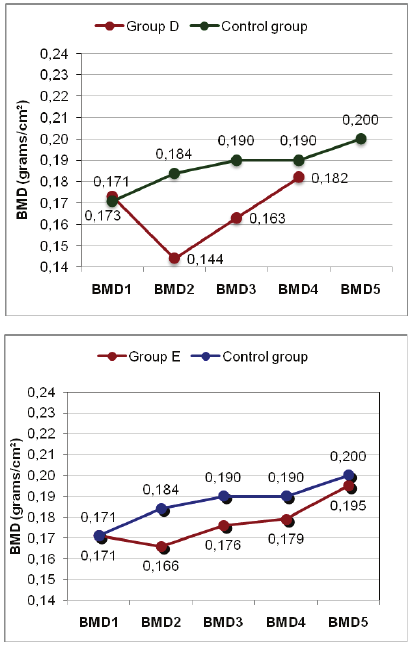
FIGURE 2 – Comparison between densitometric variables for groups A, B, C, D, E and control group